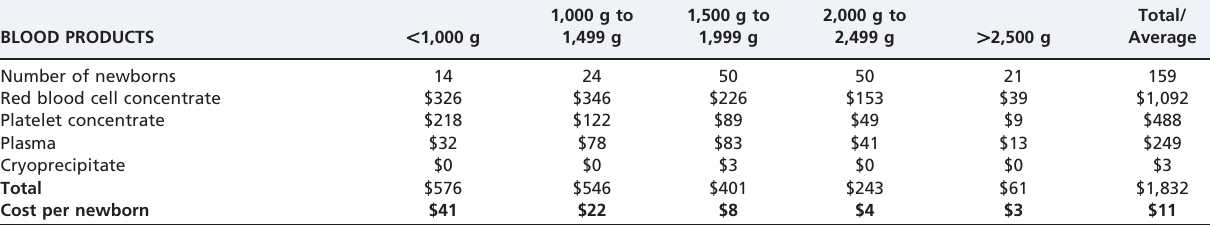
Costs listed in US dollars. Table 6 - Direct costs of hospital stays for premature newborns in the neonatal ward.